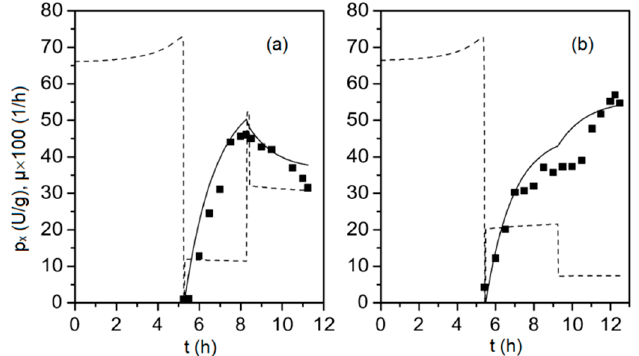
Figure 2. Specific concentration of viral capsid protein VP1, p x (solid squares) obtained from two fed-batch cultivations (subplots ( a ) and ( b ), respectively), along with the corresponding model outputs (solid line) and the biomass specific growth rate, μ (dashed line), determined from Equations (1)–(9).